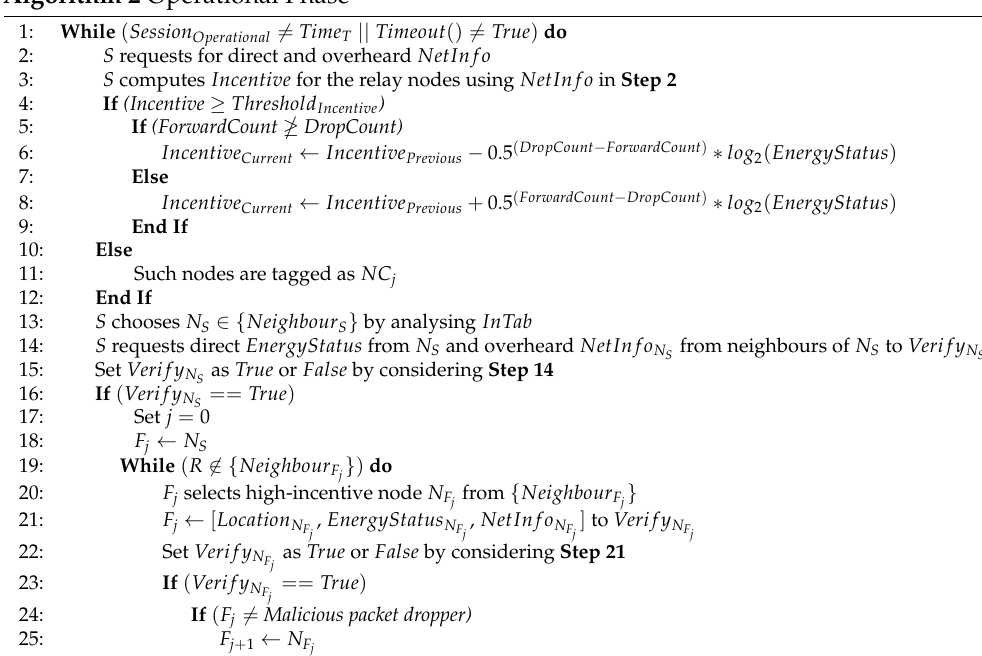
Algorithm 2 Operational